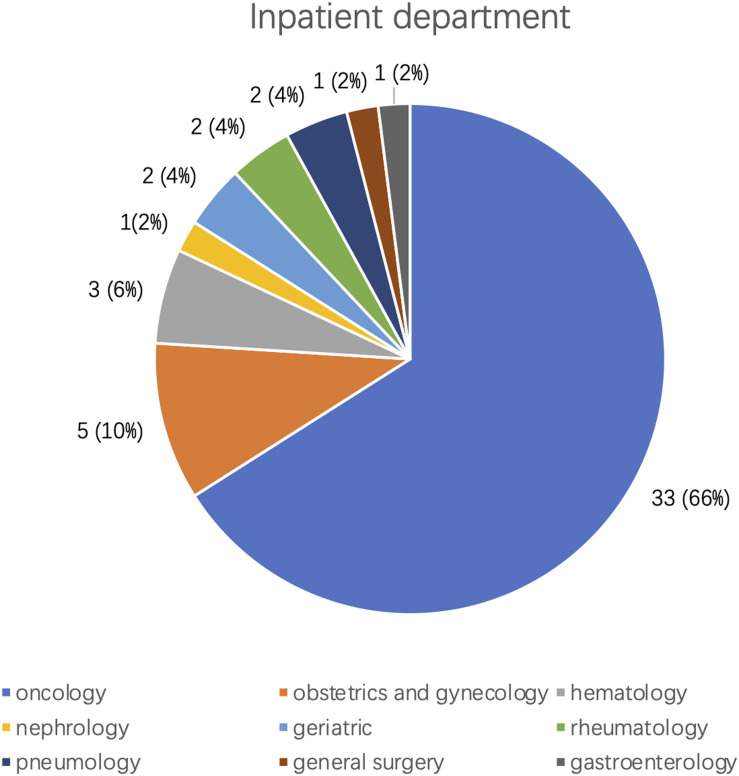
Inpatient departments distribution of the 50 patients with isolated hypomagnesemia.